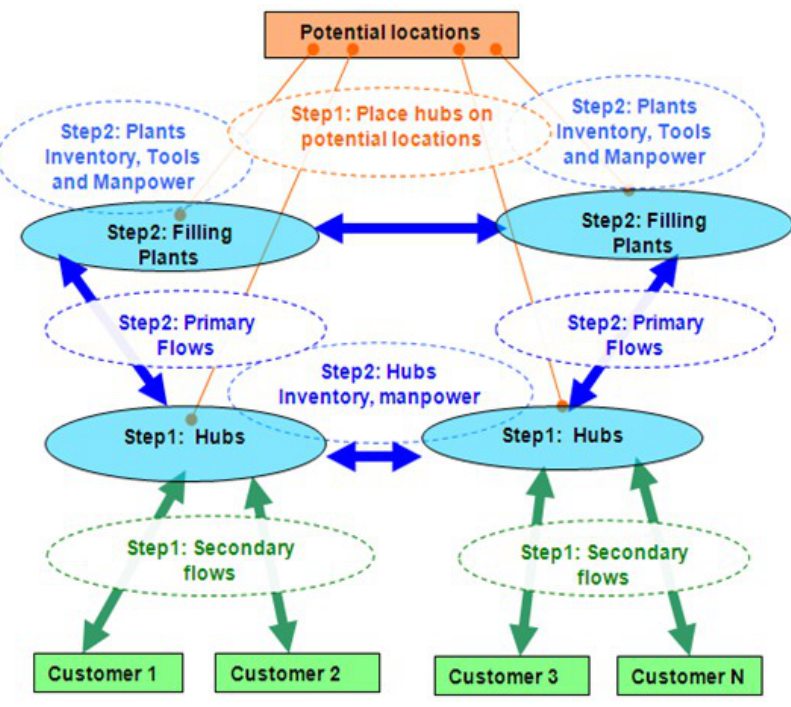
Figure 6. Two-step Decomposition